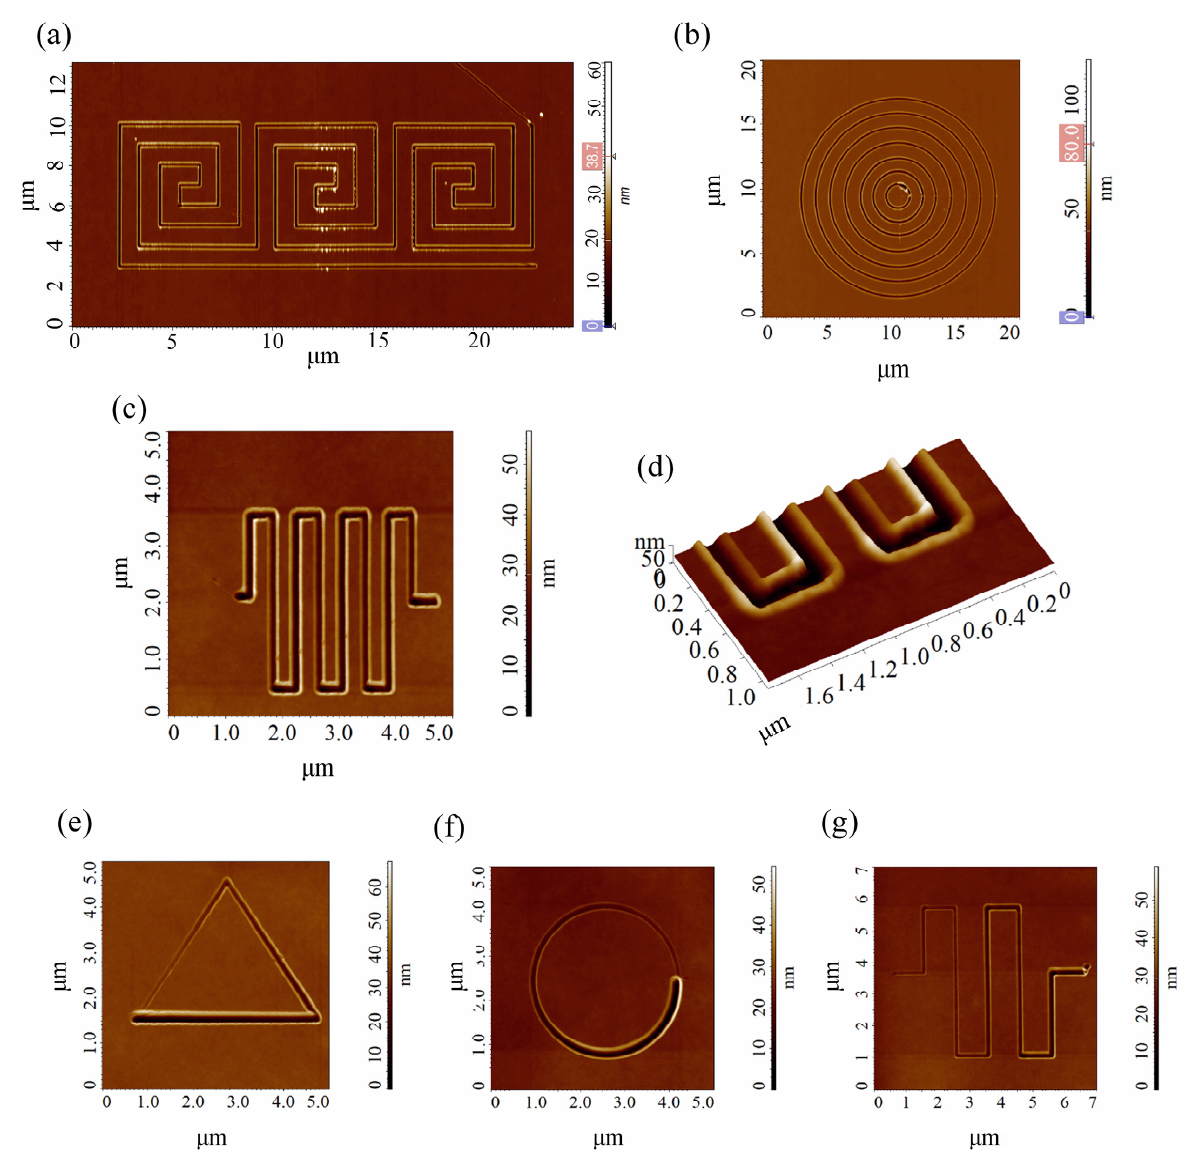
Figure 7. Two-dimensional SensHeigh AFM images of ( a ) nanolabyrinth, ( b ) an array of concentric circular-shape nanostructures, ( c ) a serpentine-like nanofluidic channel and ( d ) 3D SensHeight AFM images of nanofluidic channel loops. All these unconventional-shape nanostructures were fabricated by Constant Pulse-AFL. ( e – g ) Two-dimensional AFM images of triangular, circular, and a serpentine-like nanochannels patterned on PMMA by Gradient Pulse-AFL. The pink and blue boxes on the z-scalebar in ( a , b ) represent the minimum and maximum adjustment of the colour scale.